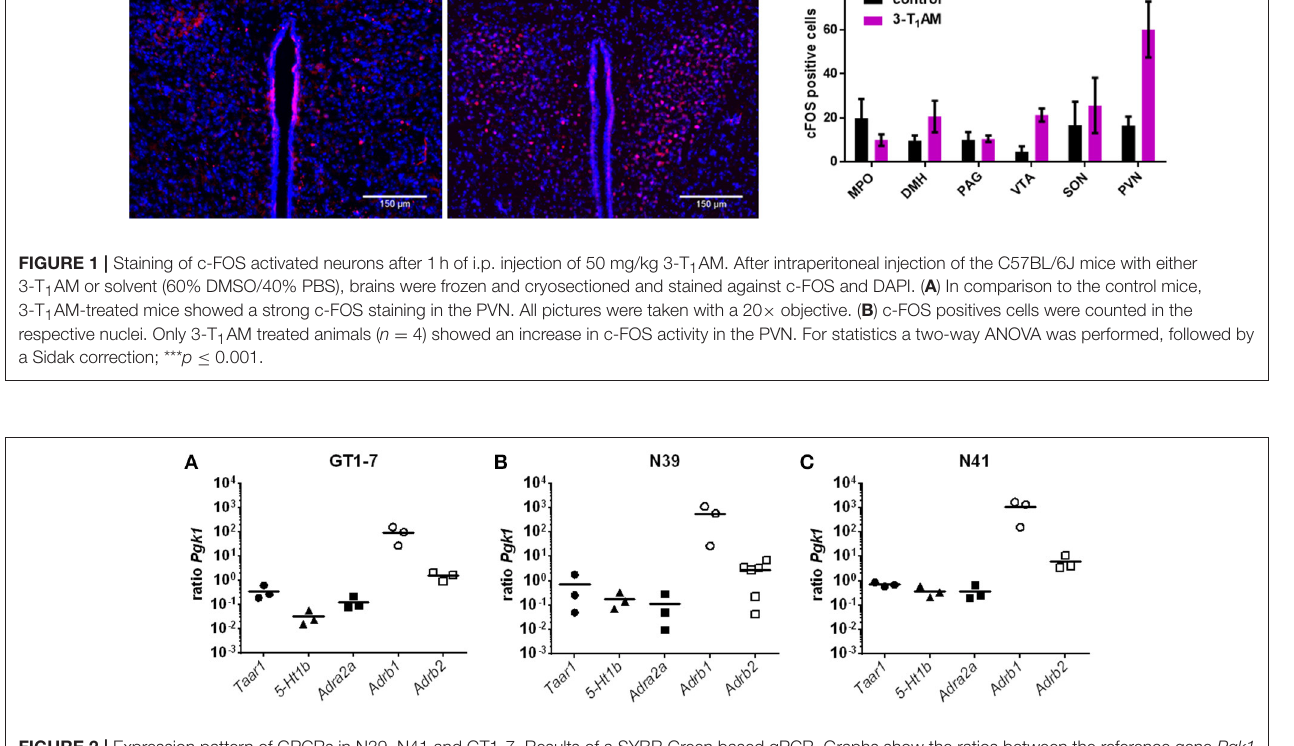
Frontiers in Endocrinology |